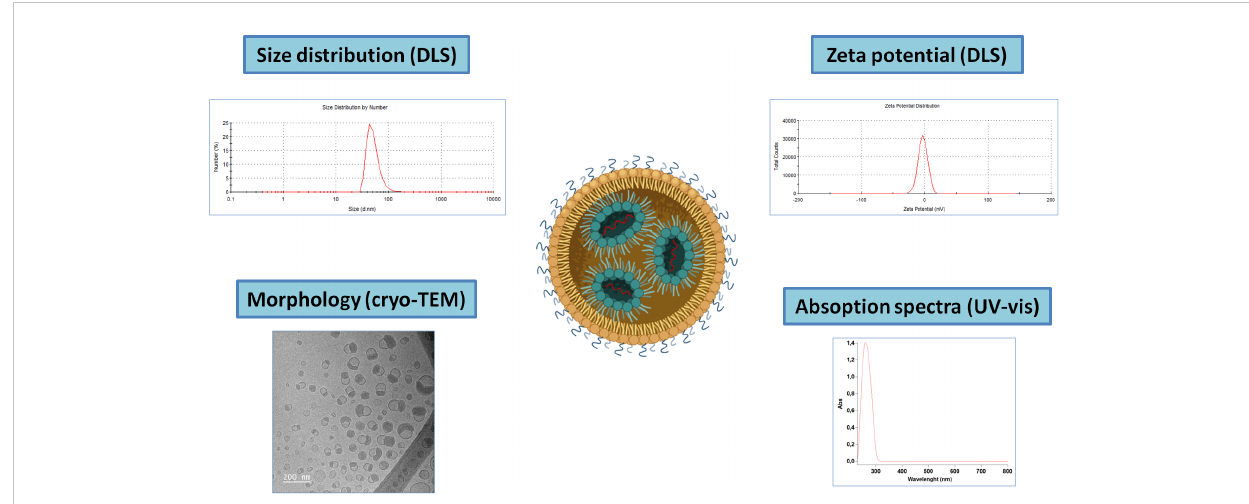
FIGURE 3 Schematic representation of the main techniques for iLNPs characterization. Note that for the UV-vis absorption spectra, the signal corresponding to the nucleic acids present in the sample will account for the majority part of the